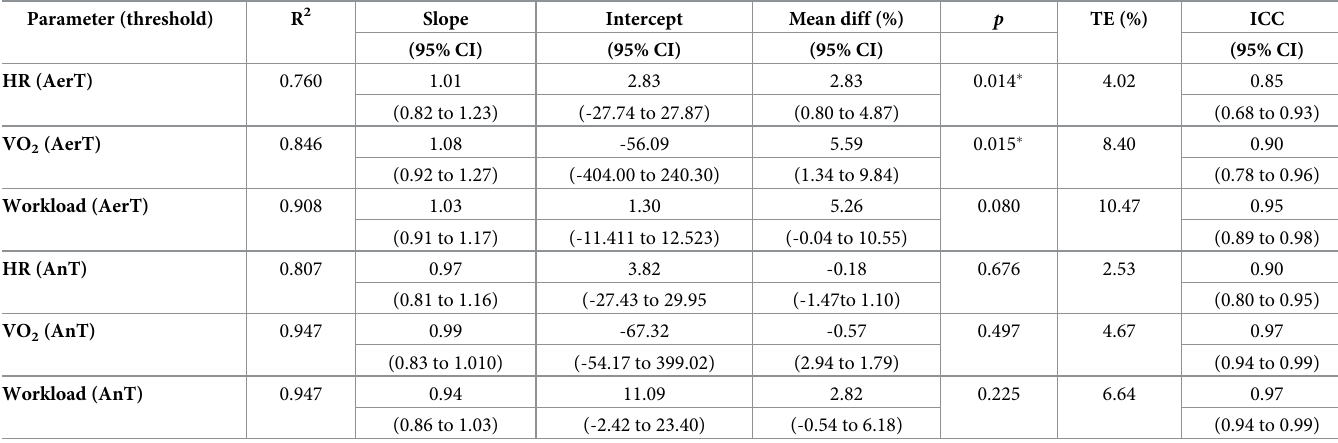
Table 4. Agreement between HR, VO 2 and workload values at AerT and AnT estimated by GE and RQA methods. Parameter